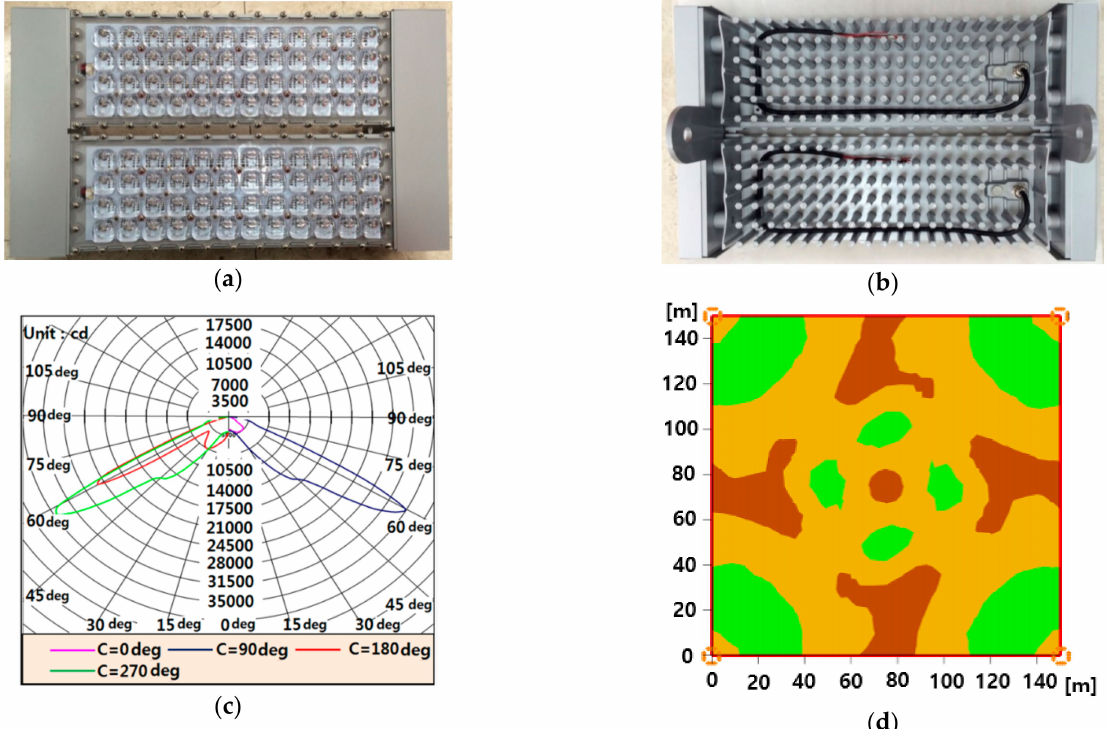
Figure 6. Fabricated seaport luminaire with a rated power of 500 W using an optimized lens and heatsink: top side view ( a ) and back side view ( b ), measured actual light distribution of single luminaire ( c ), and simulated light distribution considering the real dimensions (150 m × 150 m) of the seaport installation ( d